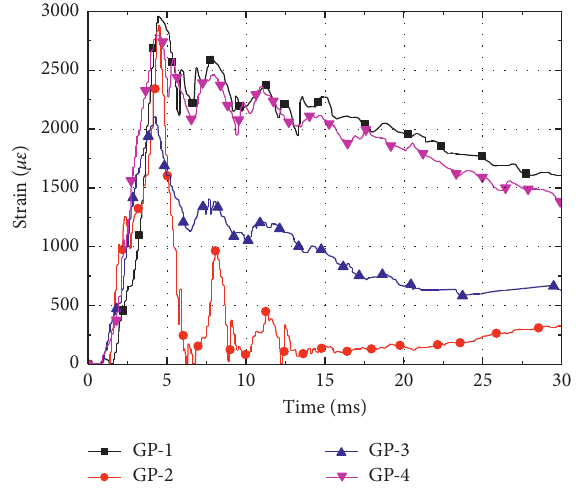
Figure 22: Strain time-history curve of ST4 collection point.